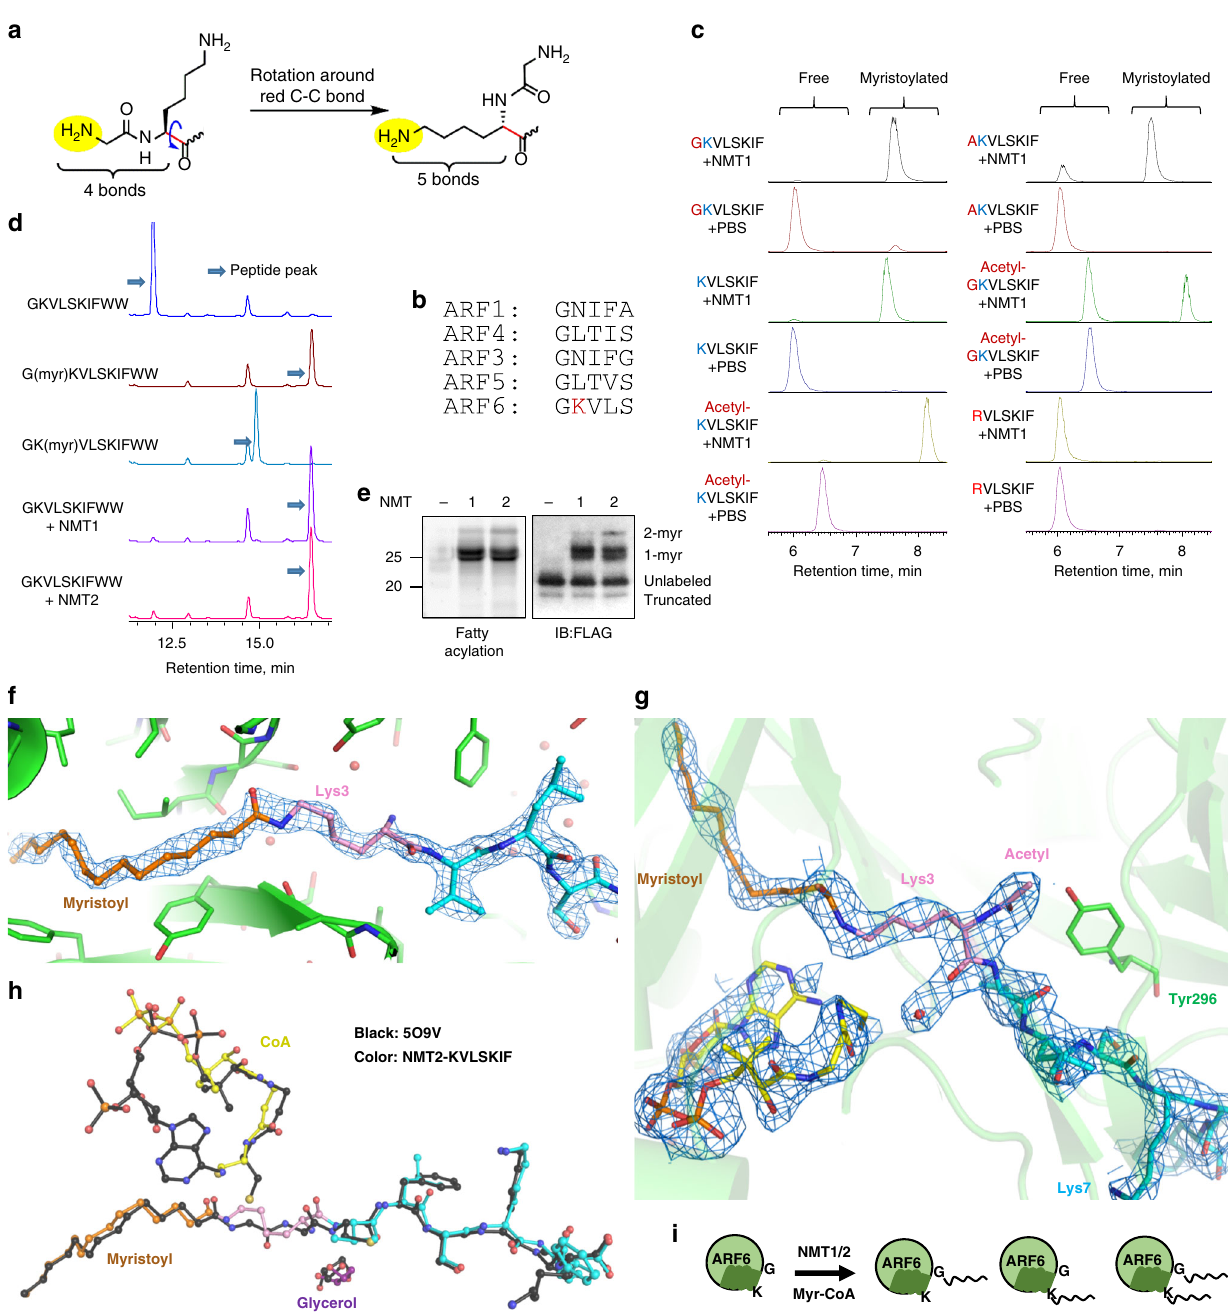
Fig. 1 NMT1 and NMT2 have lysine transferase activity and can modify ARF6 on K3. a Lysine steric properties resemble those of N-terminal glycine. b The alignment of the N-terminal sequences of human ARFs reveals a unique lysine residue in ARF6. c Monitoring NMT1 in vitro reactions on different ARF6 peptides using LC-MS. Total ion chromatograms searched for the substrate and product ions are shown. d HPLC separation of NMT reaction on ARF6 WT N-terminal peptide reveals mostly glycine myristoylated product. e NMT reaction with ARF6 WT protein and Alk12-CoA generates several modi fi ed species. Shown are in-gel fl uorescence and FLAG western blot after TAMRA azide conjugation via click chemistry. f Simulated annealing omit 2 F O – F C map (at 1.2 σ ) surrounding the myristoyl-KVLSKIF product in NMT2. Peptide: cyan, Lys3: pink, myristoyl: orange. g Myristoyl – peptide and CoA products bound to chain A in the NMT1 myristoyl-AcKVLSKIF structure. The 1.0 σ 2 F O – F C electron density map around the ligands is shown (blue mesh). h Comparison with PDB structure 509V (black), NMT1 containing myristoyl-glycine peptide product. i Model showing that NMT1 and NMT2 enzymes can modify G2, K3 of ARF6, or